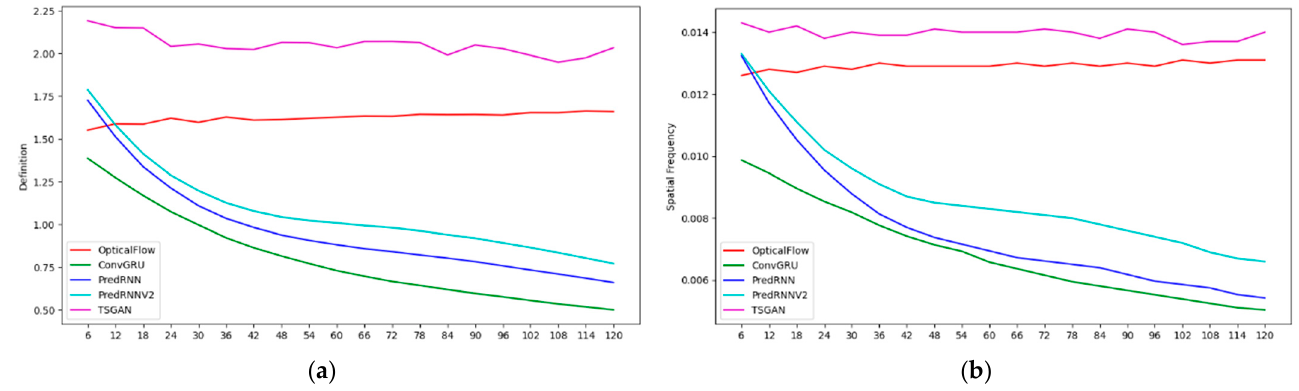
Figure 9. The scores of the spatial details for the forecasts of the squall line process. (a) Definition; (b) Spatial frequency.